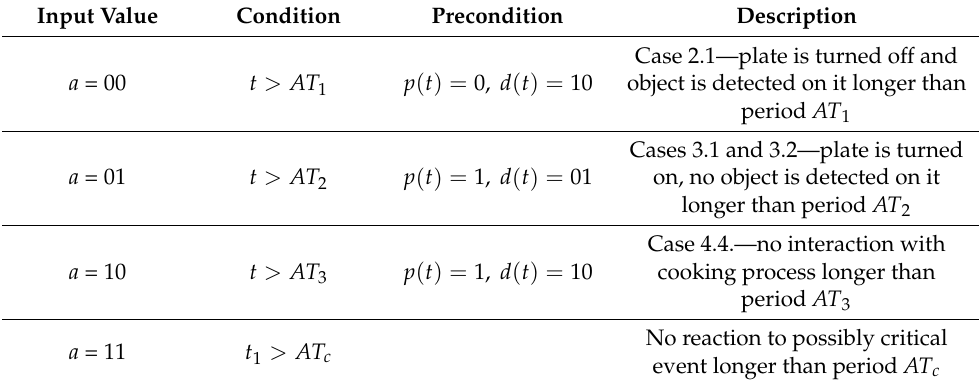
Table 2. Values of the alarm parameter a